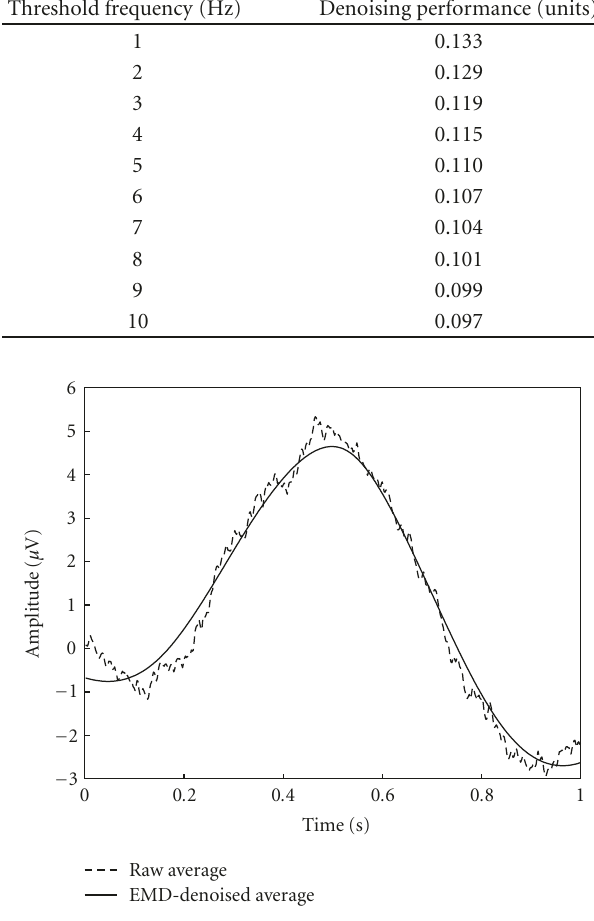
Figure 3: EMD-denoised average superimposed on raw average. Threshold frequency was 1Hz, calculated according to the criterion in